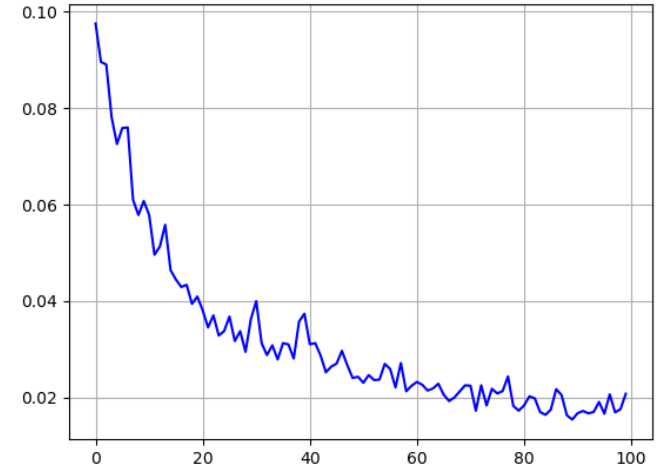
Figure A2. GOLD Losses , 45 s.